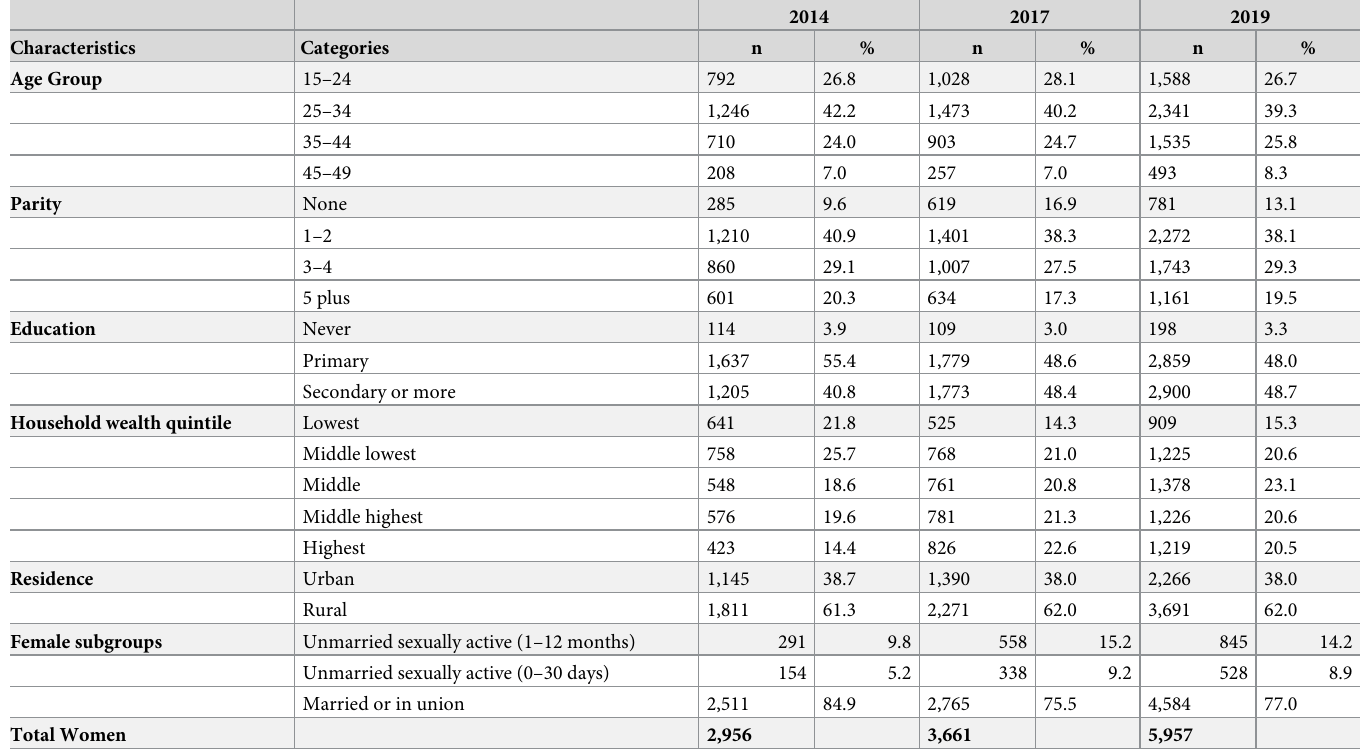
Table 2. Background characteristics for women aged 15–49, PMA/Kenya (2014, 2017,